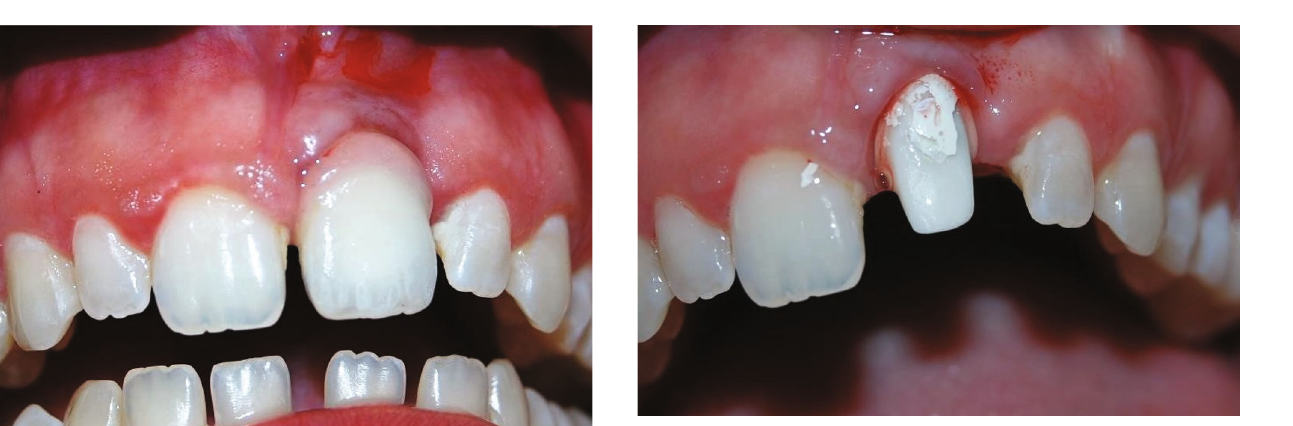
Figure 2: Once the crown was removed, the stump was newly prepared with a diminishing edge in zirconium and a temporary therapeutic element.